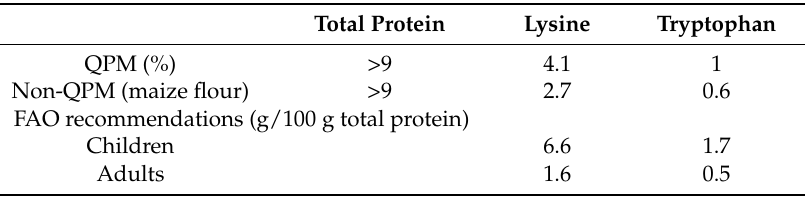
Table 2. Proportion of lysine and tryptophan in the total protein of non-QPM, QPM material, and the recommended protein proportion for children and adults. Total